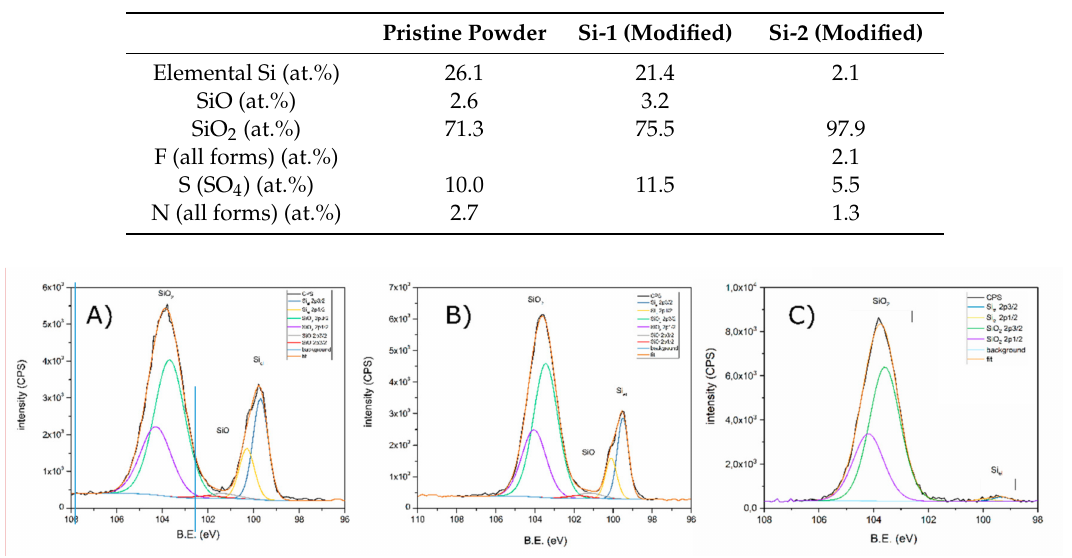
Table 1. Surface atomic concentration of di ff erent elements / compounds found by XPS analysis.